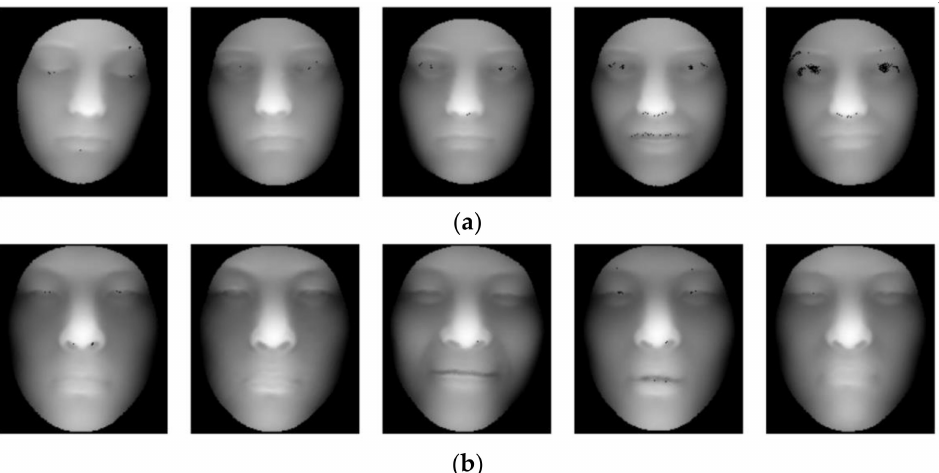
Figure 2. Transformed face depth images from 3D face data. ( a ) Six different expressions of Person A. ( b ) Six different expressions of Person B. The face expressions from the left to the right by column are expressionless, frowning, smiling, surprised, and small changes in